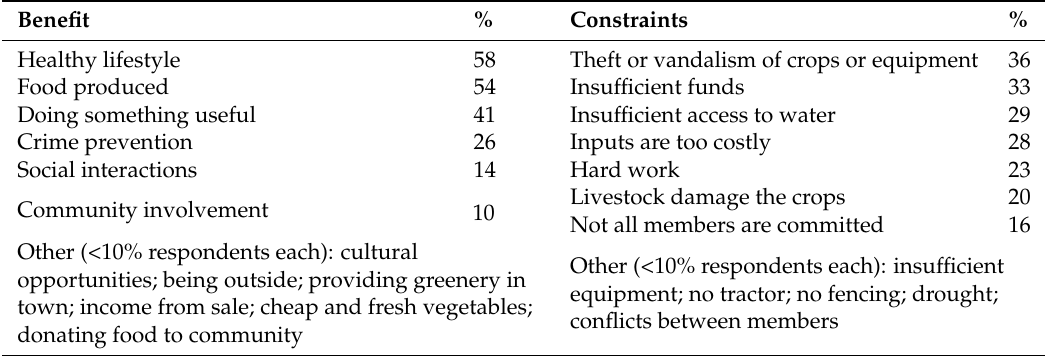
Table 3. Respondents’ perceptions of benefits from and challenges to urban community gardening.